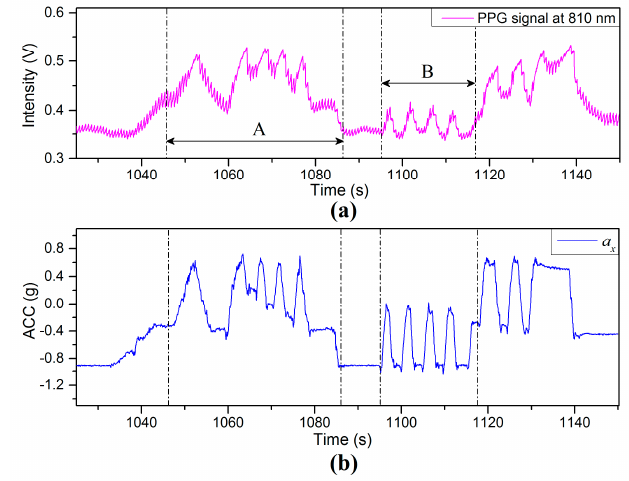
Figure 18. ( a ) PPG and ( b ) ACC signals captured in the process of swinging the arm up and down with short resting time intervals.